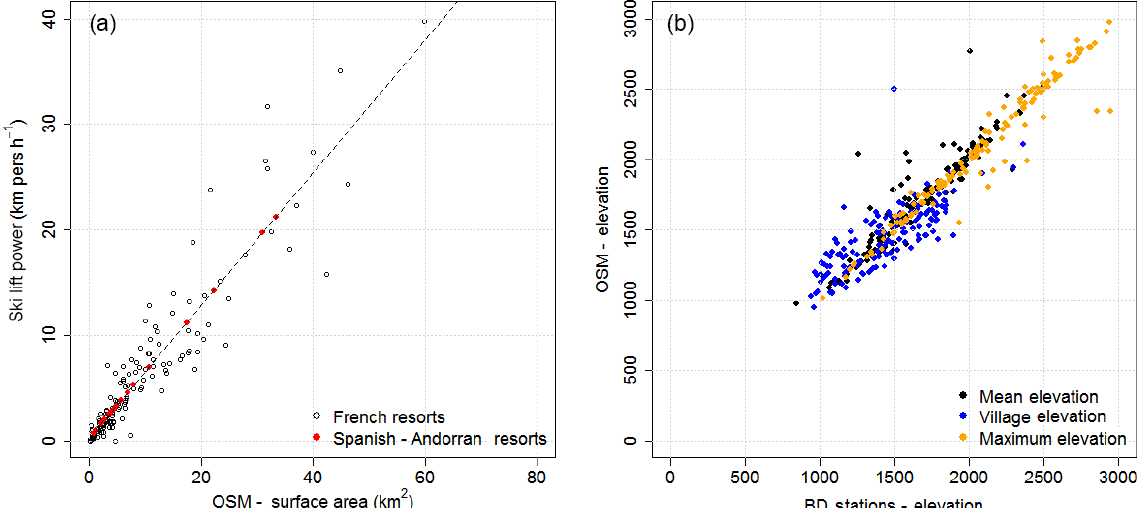
Figure 1. Relationship between OpenStreetMap (OSM) data on French ski resorts and ski lift power (SLP) and elevations of the ski resort (min, mean, max), used to estimate similar indicators in ski resorts in Spain and Andorra. In panel (b) , “BD Stations” refers to the database of French ski resorts used in this study (see text for details).